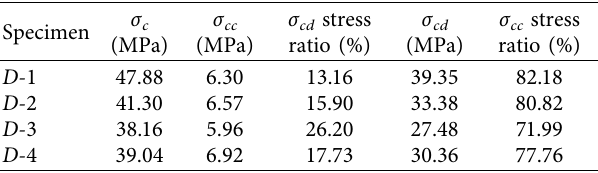
Figure 7: Stress-strain curve in uniaxial compression test and characteristic stress. Table 2: Characteristic stress value in the process of graded loading of concrete sample.